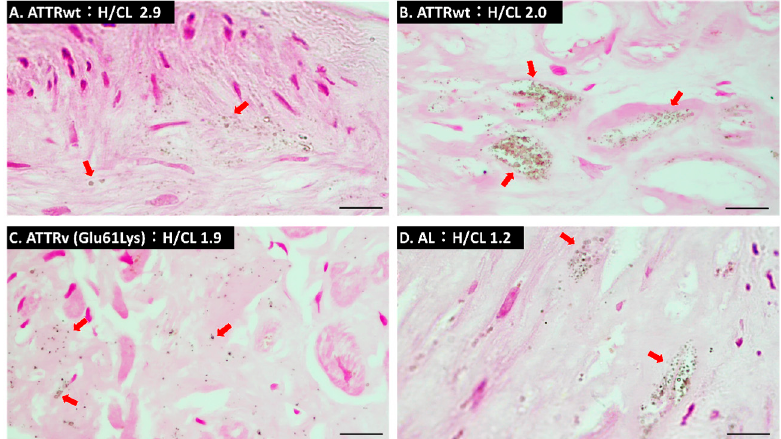
Figure 2. von Kossa staining of myocardial tissues. ( A ) von Kossa staining of a slice obtained from a patient with wild-type transthyretin cardiac amyloidosis (ATTRwt-CA) whose heart-to-contralateral (H/CL) ratio was 2.9. ( B ) von Kossa staining of a slice obtained from a patient with ATTRwt-CA whose H/CL ratio was 2.0. ( C ) von Kossa staining of a slice obtained from hereditary ATTR (ATTRv-CA) whose H/CL ratio was 1.9. ( D ) von Kossa staining of a slice obtained from a patient with amyloid light-chain cardiac amyloidosis (AL-CA) whose H/CL ratio was 1.2. Red arrows indicate von Kossa-positive microparticles. Scale bars are 10 µm. Table 2. Percentage of von Kossa-positive samples.